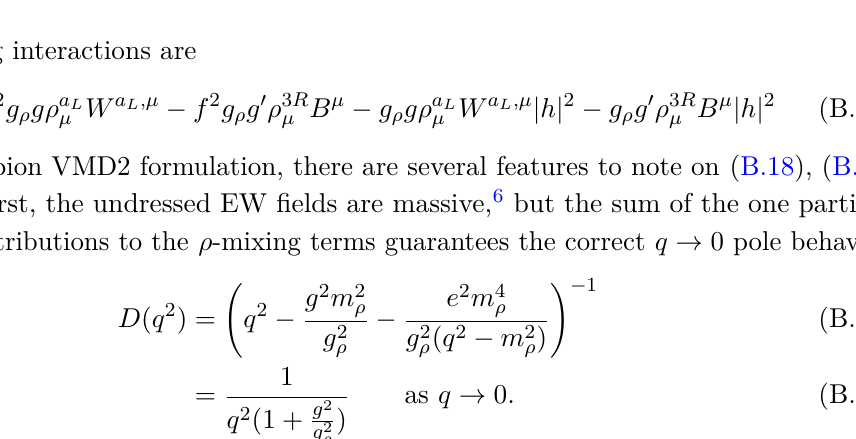
Figure 15 . Higgs form factors obtained in the different VMD basis for the MCHM 5